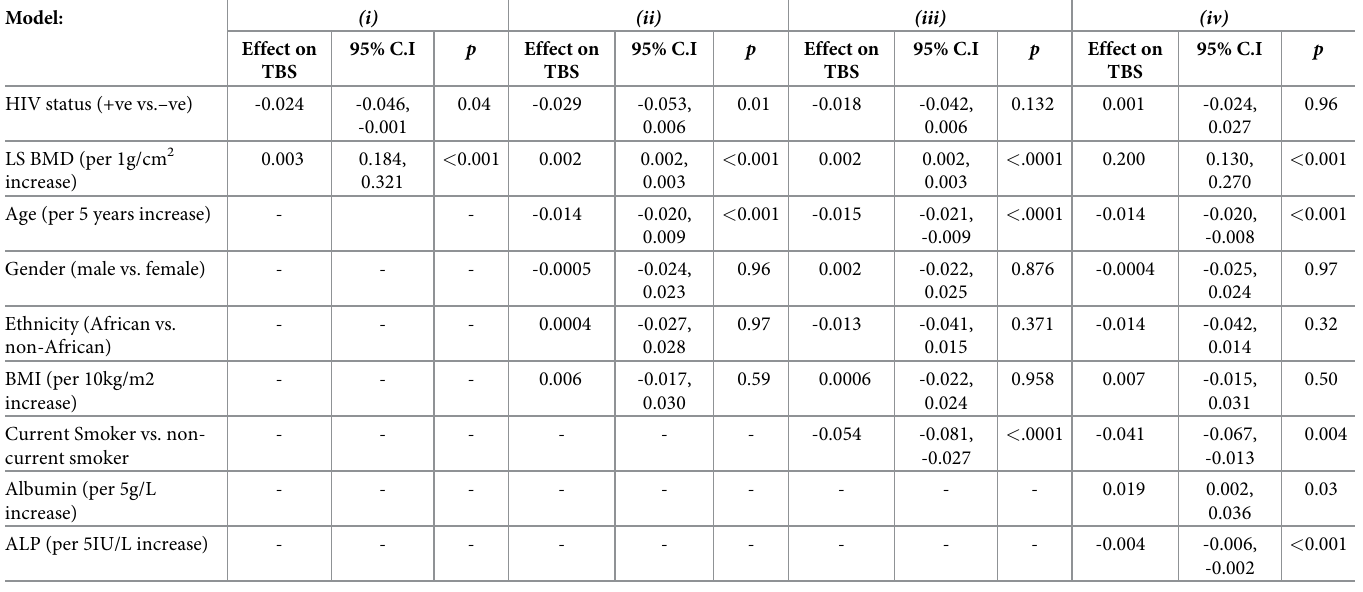
Table 2. Parameter estimates (effect of each parameter on the mean value) and 95% confidence intervals (95% C.I.) from a series of multivariable linear regression models to identify factors associated with TBS in the HIV UPBEAT cohort. Model: